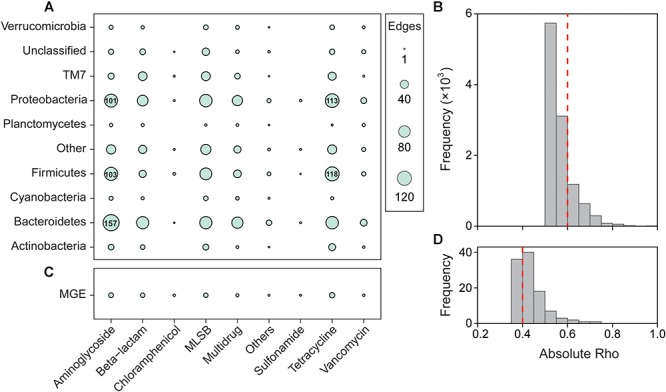
Significant correlation among bacterial OTUs, ARGs, and MGEs. Classification of nodes within the network depicting the co-occurrence patterns of microbial taxa and ARGs (A), MGEs and ARGs (C). Other, other bacterial phyla; others, other ARGs. The Spearman’s absolute rho was calculated at OTU and ARG subtype levels, and the number of edges was summarized at phylum and type levels, respectively. The edges correspond to a strong (Spearman’s |ρ| > 0.6 for microbial taxa and ARGs, Spearman’s |ρ| > 0.4 for MGEs and ARGs) and significant (P < 0.01) correlation between nodes. Frequency distributions of correlation coefficients between ARGs and microbial taxa (B) and between ARGs and MGEs (D) at P < 0.01.